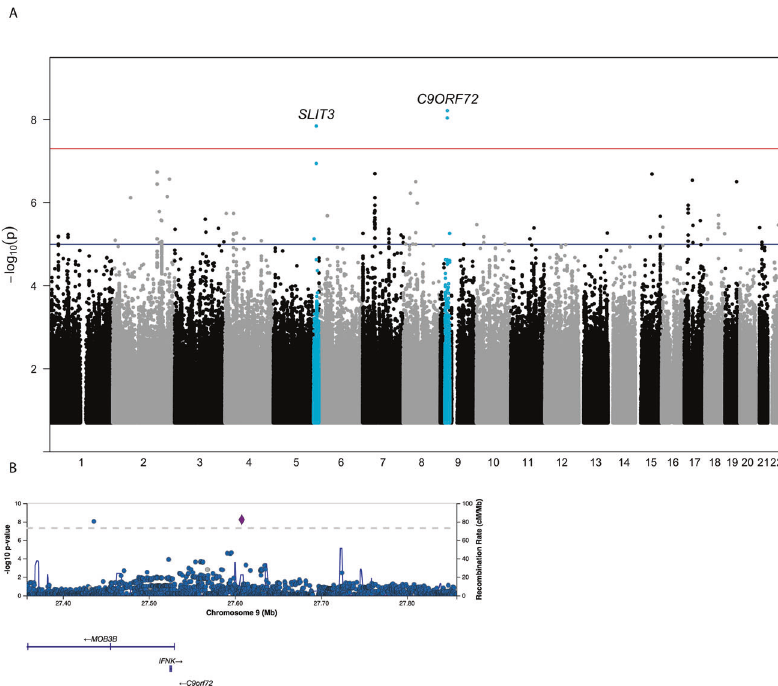
Fig. 1 Manhattan plot and regional plot of the discovery analysis on the genome-wide association with frontotemporaldementia. A Manhattan plot. The discovery analysis included N = 354 FTD patients and N = 4209 controls. The genome-wide signi fi cance threshold ( p < 5 × 10 − 8 ) has been highlighted in red and the suggestive signi fi cance threshold ( P < 1 × 10 − 5 ) is depicted in blue. For each genome-wide signi fi cant locus, loci are named by the closest located gene. B Regional plot for the C9ORF72 locus on chromosome 9. The genetic variant depicted in purple represents the strongest associated variant. Abbreviation(s) FTD: frontotemporal dementia, C9ORF72: chromosome 9 open reading frame 72, SLIT3: Slit Guidance Ligand